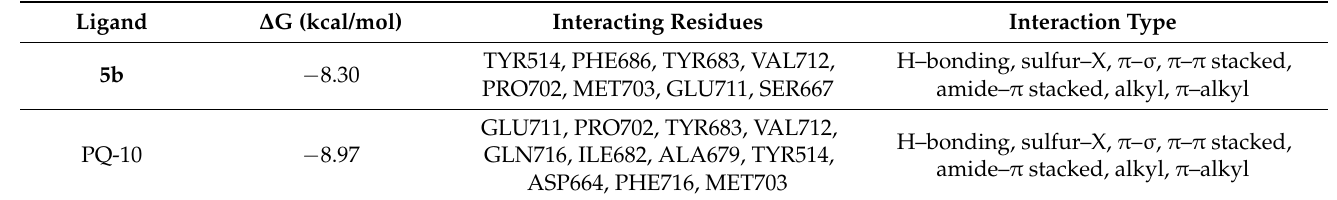
Table 2. The IFD parameters of 5b and PQ-10 simulated in the active site of PDE10A.